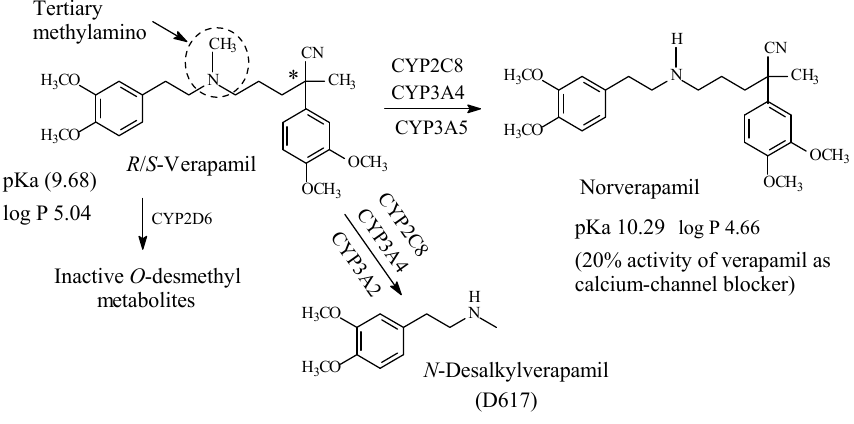
Figure 29. Metabolic pathways of verapamil.